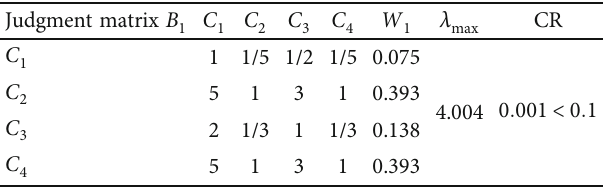
Table 13: Judgment matrix of mine geological index.